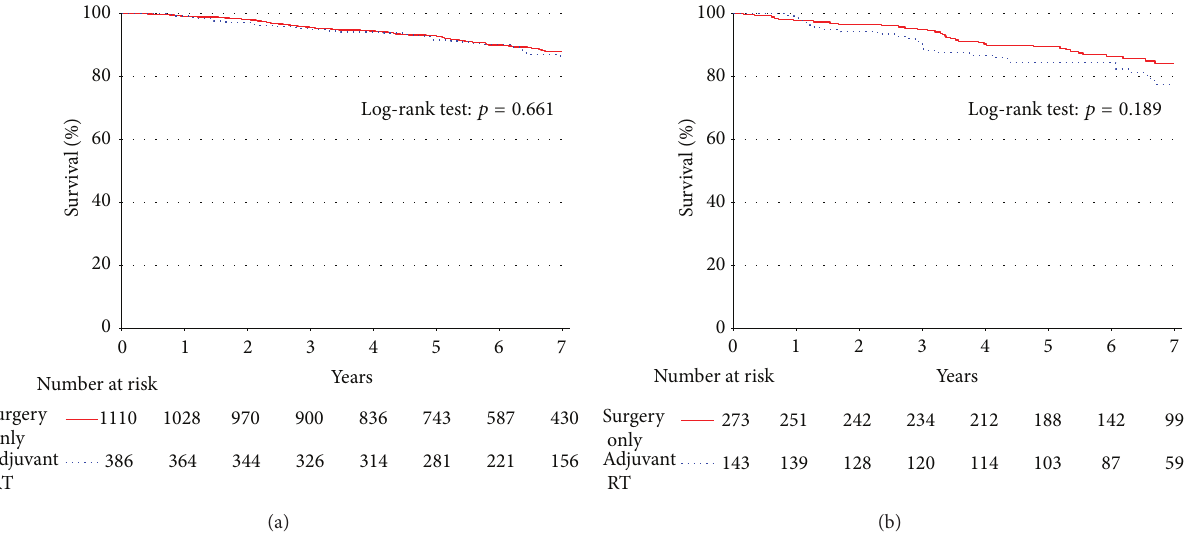
Figure 2: There is no difference in unadjusted survival for (a) patients with well-differentiated tumors when stratified by adjuvant RT versus surgery on the basis of negative margins. There was also no difference when stratified on the basis of positive margins (b).